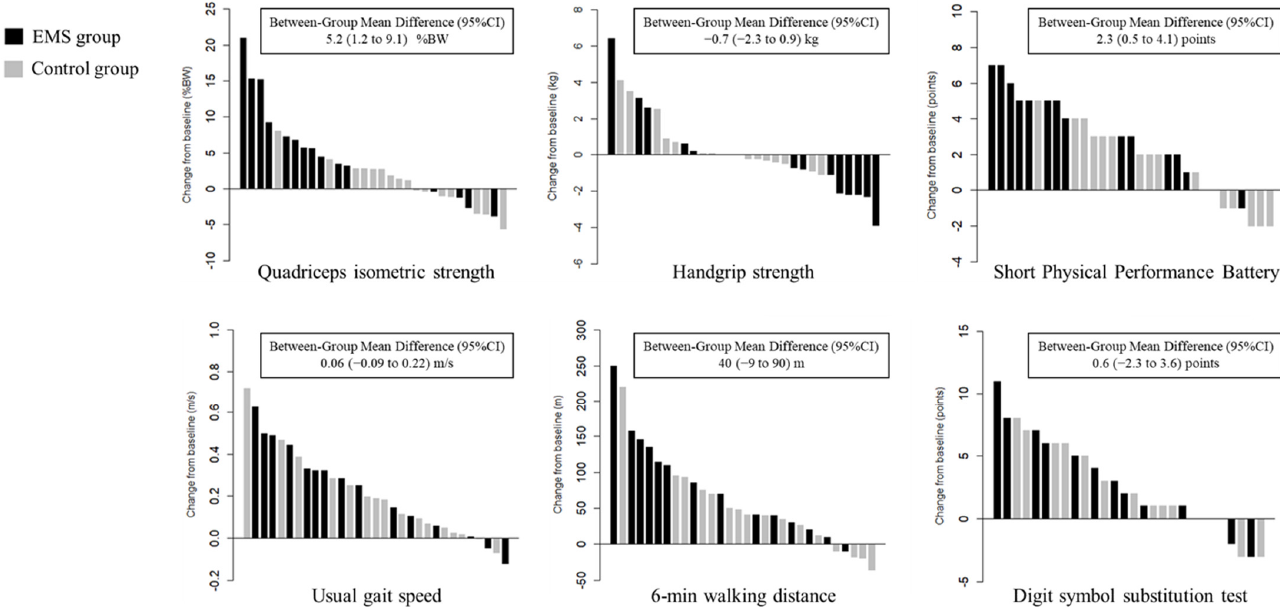
Figure 3. Waterfall plots of changes in physical and cognitive function. BW, body weight; CI, confidence interval; EMS, electrical muscle stimulation.